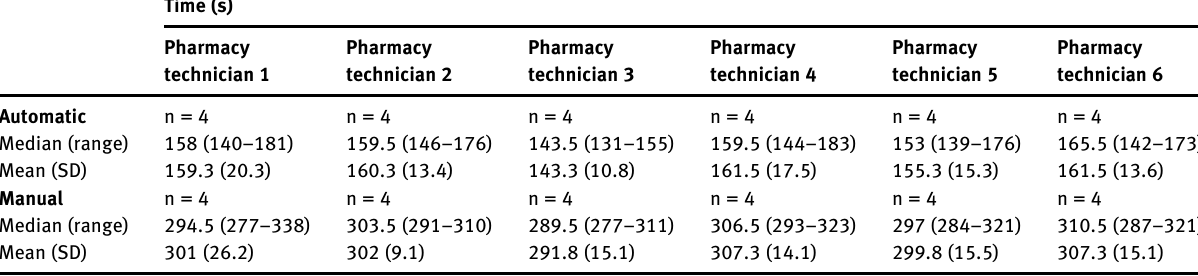
Table  : Automatic and manual fi lling times depending on the pharmacy